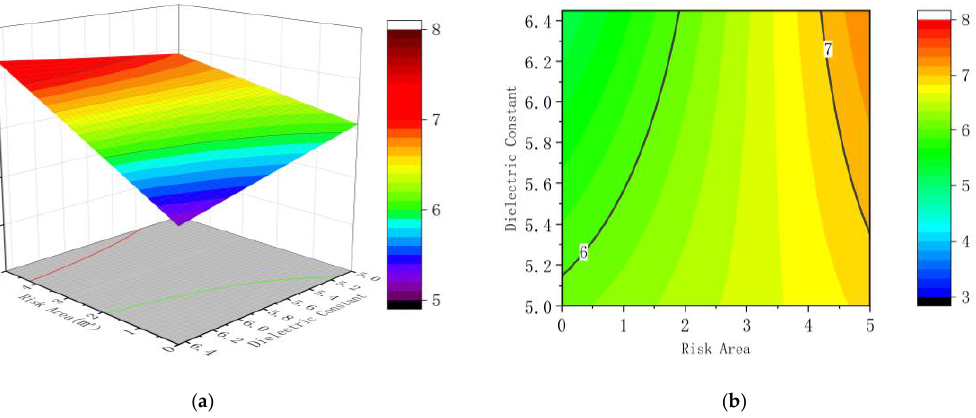
Figure 13. Response surface diagram and contour diagram of the dielectric constant and the risk area to the void ratio; ( a ) the response surface diagram ( b ) the contour diagram.